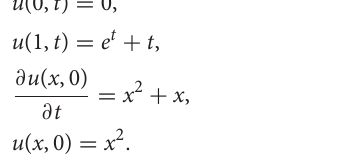
FIGURE 10 | Variation of u with m = 10 and x = 0.1 at different value of α